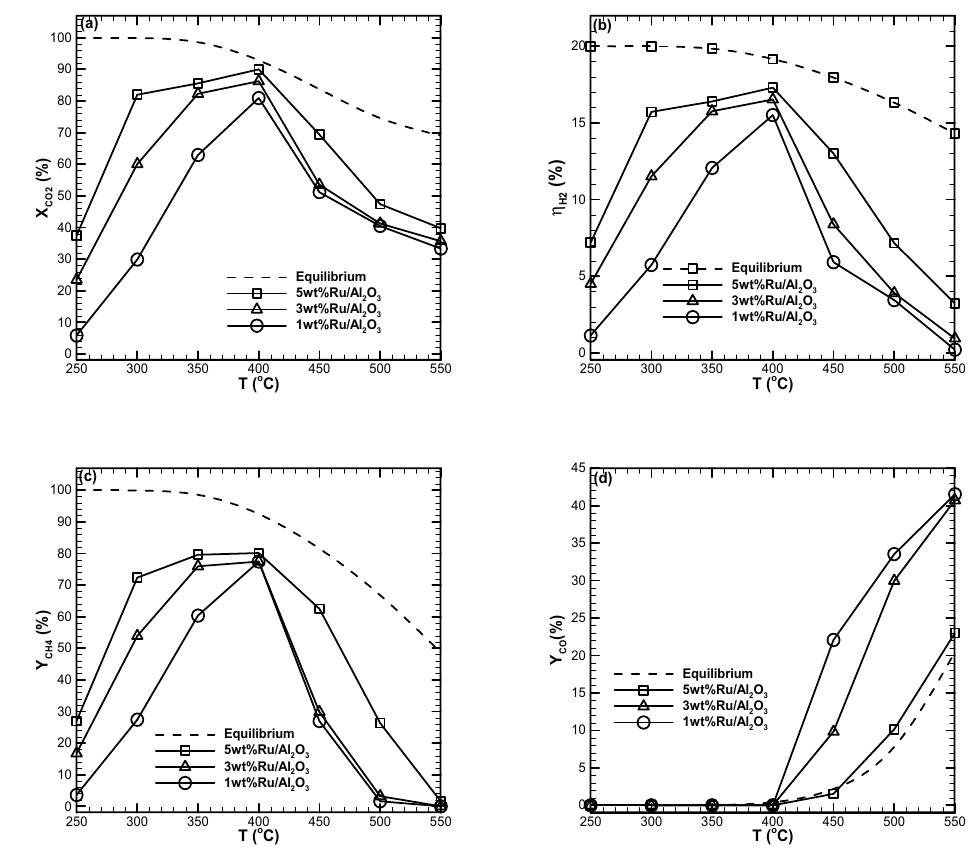
Figure 5. Averaged CO 2 methanation performance as a function of the temperature using Ru catalyst based on time on stream measurement. ( a ) CO 2 conversion, ( b ) H 2 efficiency, ( c ) CH 4 yield, and ( d ) CO yield.